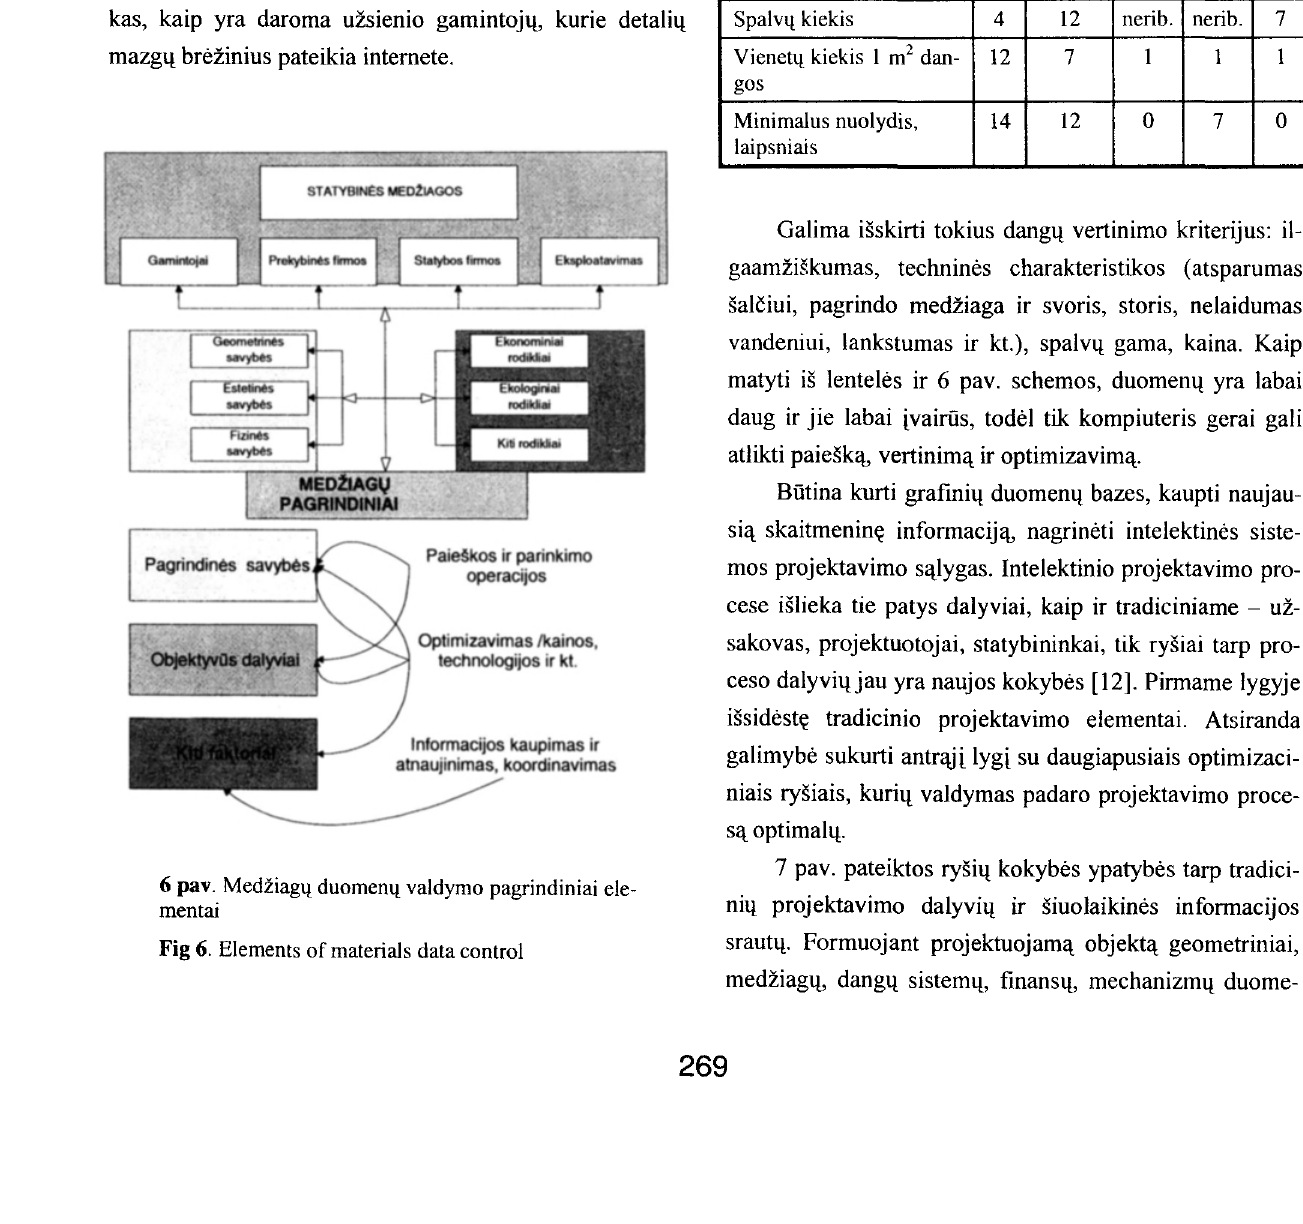
Fig 6. Elements of materials data